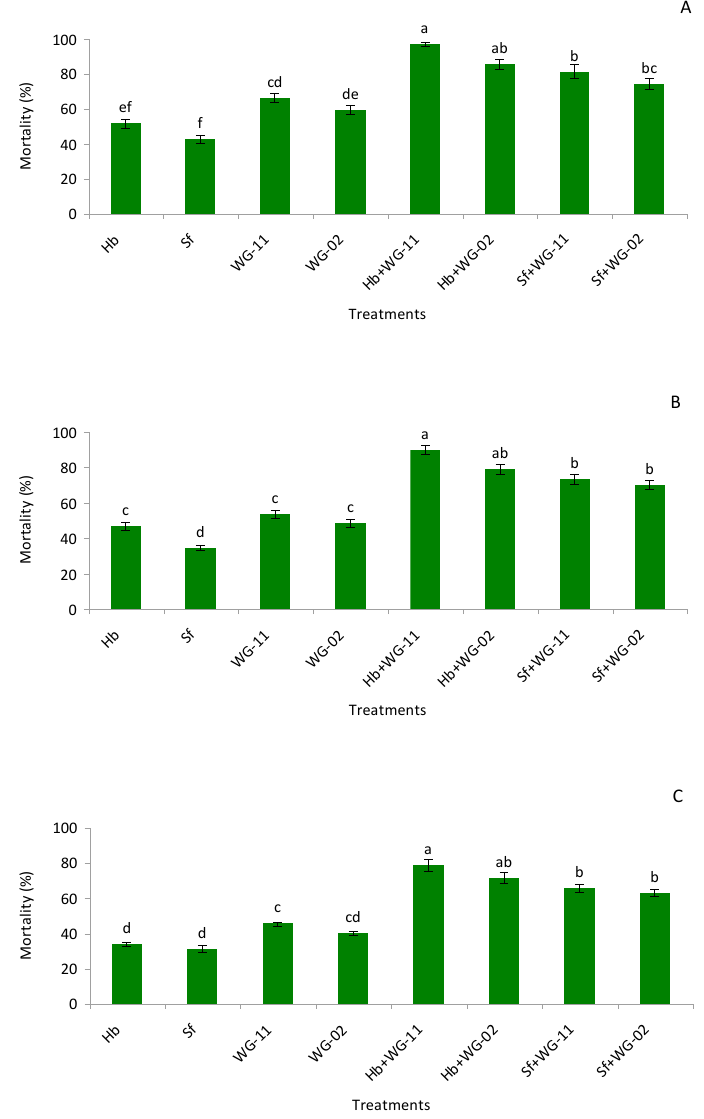
Figure 2. Mean (% ± SE) mortality of pre-pupae ( A ), pupae ( B ) and late last instar larvae ( C ) of Thrips tabaci when treated with Hb = Heterorhabditis bacteriophora , Sf = Steinernema feltiae , WG-11 = Beauveia bassiana (WG-11), WG-02 = Metarhizium anisopliae (WG-02), Hb + WG-11 = H. bacteriophora + B. bassiana , Hb + WG-02 = H. bacteriophora + M. anisopliae , Sf + WG-11 = S. feltiae + B. bassiana , Sf + WG-02 = S. feltiae + M. anisopliae in a laboratory potted soil bioassay. Different letters above the bars indicate statistical significance ( p < 0.05; Tukey’s test).